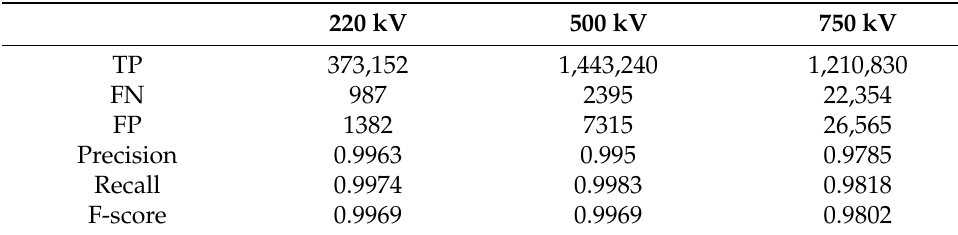
Table 2. Classification accuracy of power line points.